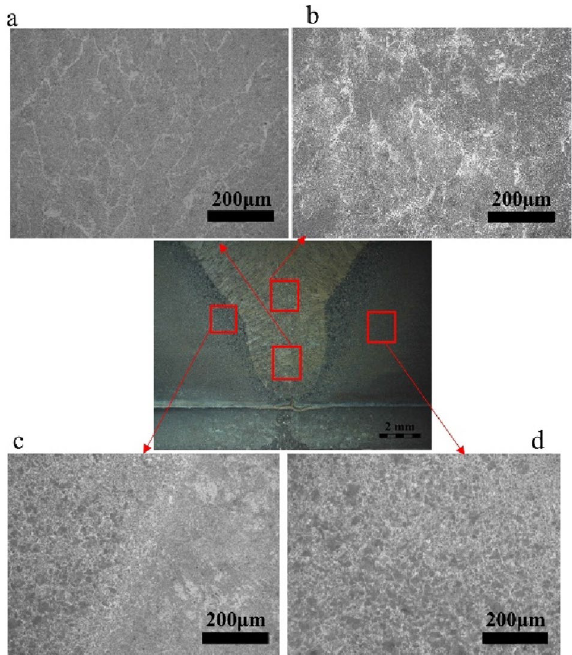
Figure 2. Microstructure of the Q235 steel side for the first welding parameter.